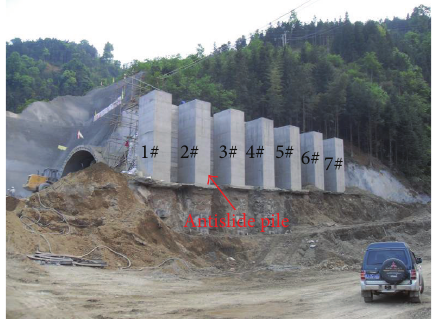
Figure 9: Ruipo tunnel portal on the Shui-Du